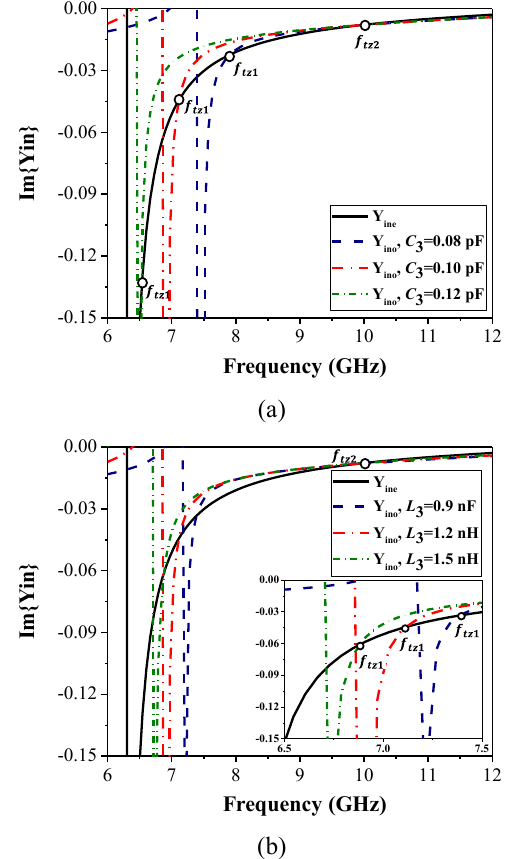
Figure 4: Relations between the even and odd mode input admittances and transmission zeros for the proposed LUC ( L 1 =0.9 nH, C 1 =0.1 pF, L 2 =0.4 nH and C 2 =0.4 pF are fixed) under different values of (a) C 3 (with L 3 =1.2 nH) and (b) L 3 (with C 3 =0.1 pF).